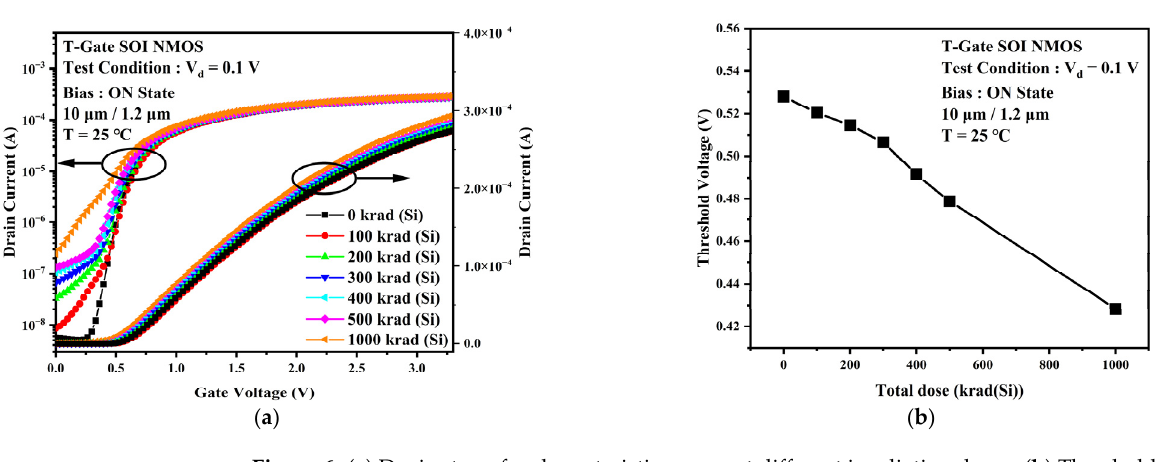
Figure 6. ( a ) Device transfer characteristic curves at different irradiation doses. ( b ) Threshold voltage at different irradiation doses.